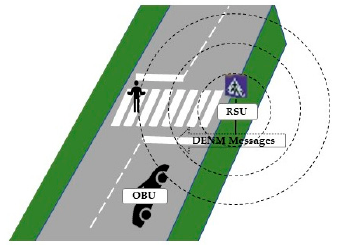
Figure 6. Typical RSU operating scenario.